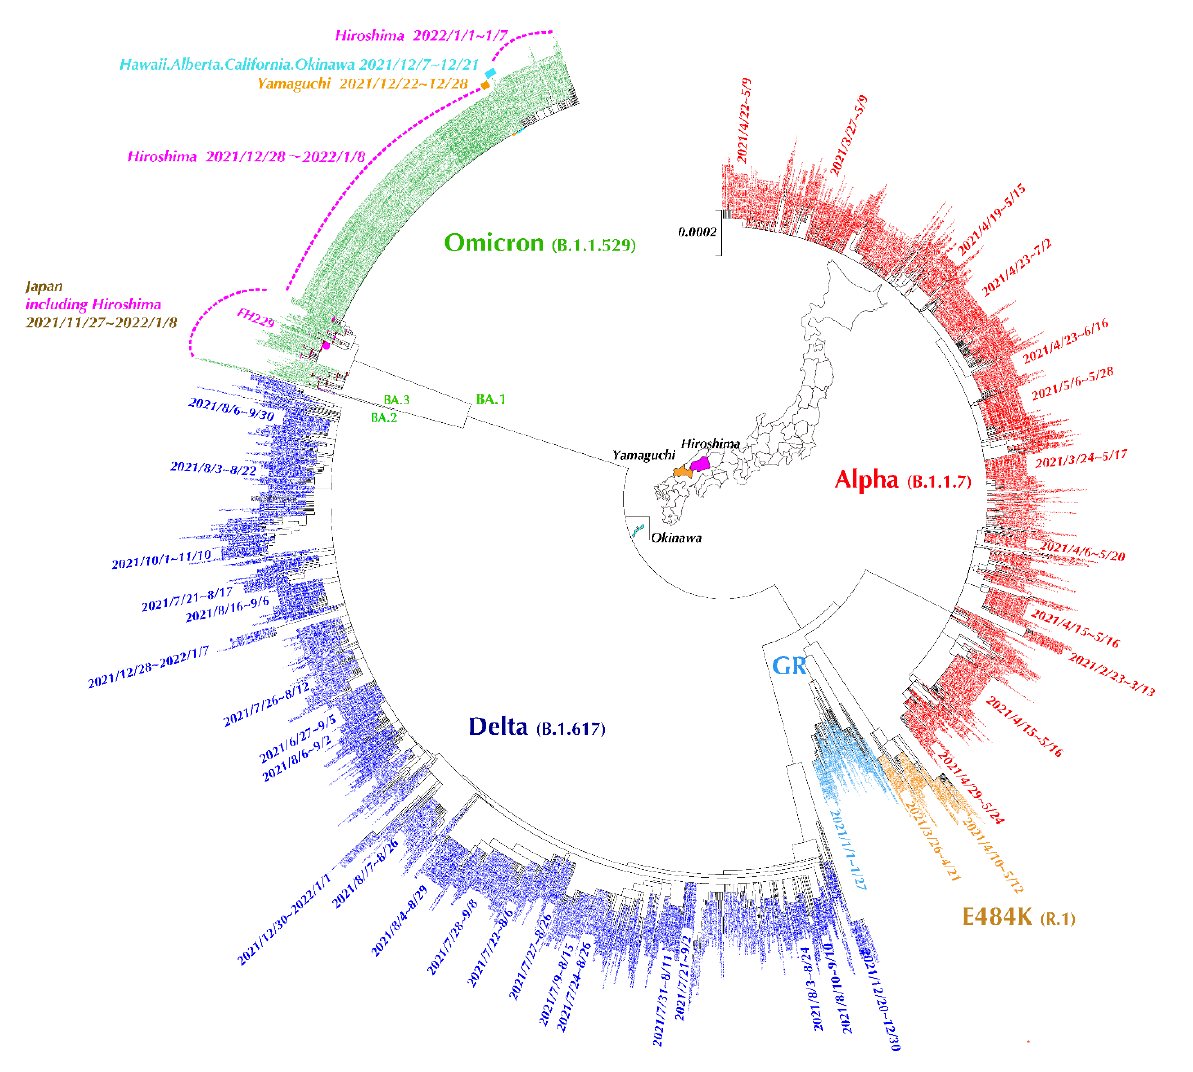
Figure 5. Phylogenetic tree of SARS-CoV-2 isolates detected in Hiroshima. Each variant is shown with a specific color: red for Alpha variant, dark blue for Delta variant, yellow for lineage R.1, green for Omicron, and light blue for GR clade.